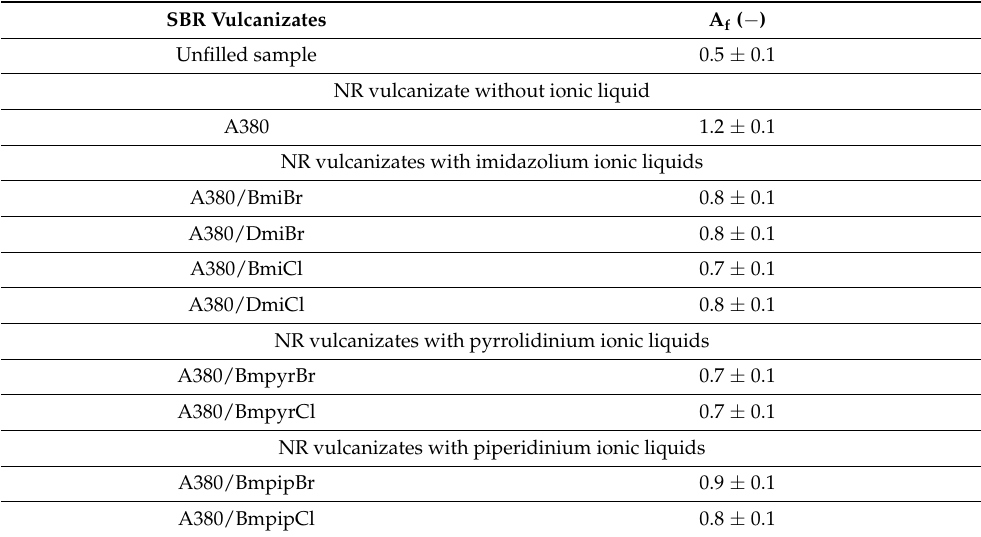
Table 8. Thermo-oxidative aging factor (A f ) of the silica-filled NR vulcanizates containing ILs.